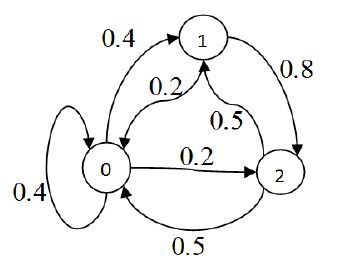
Figure 5. Sample M/M/1/2